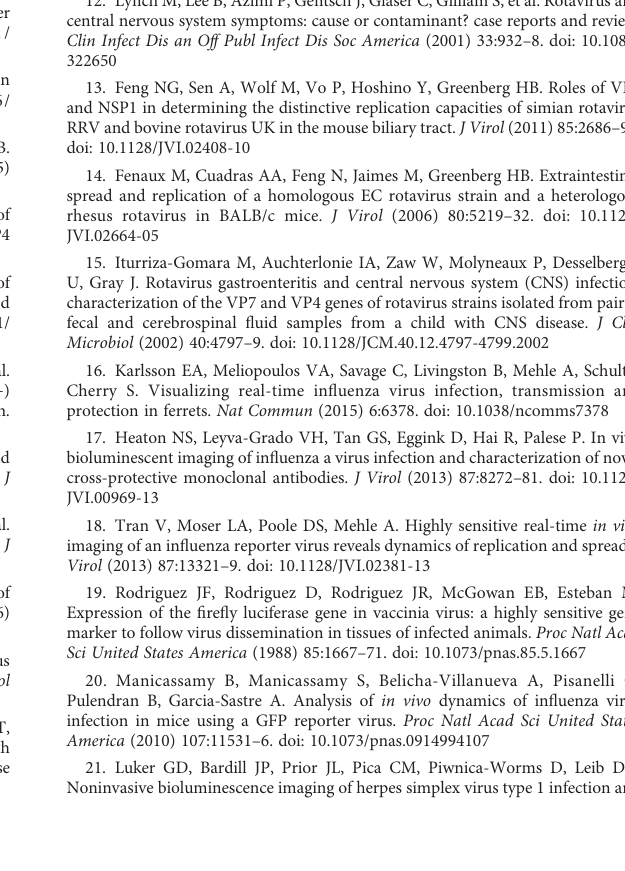
SUPPLEMENTARY FIGURE 2 The NSP3 sequences from shed virus of infected mice. The sequences of NSP3 of parental and virus collected in the stool sample of infected mice at8dayspostinfectionwereanalyzedbyRT-PCRandSangersequencing. The NSP3, P2A, and NLuc junctions were